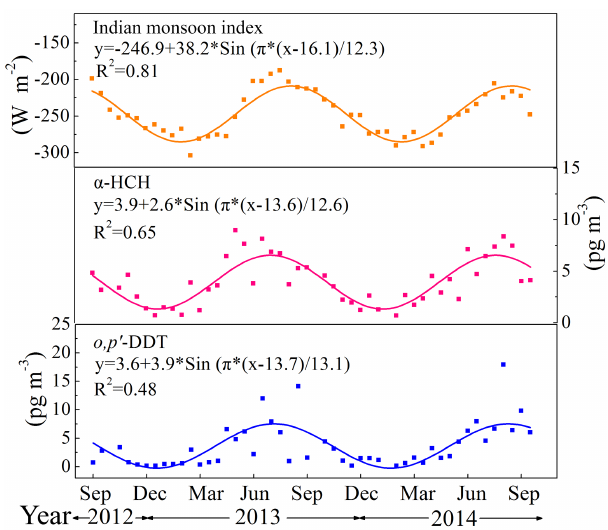
Figure 3. Seasonal patterns of the Indian monsoon index, the atmo- spheric concentrations of α -HCH and o,p (cid:48) -DDT.